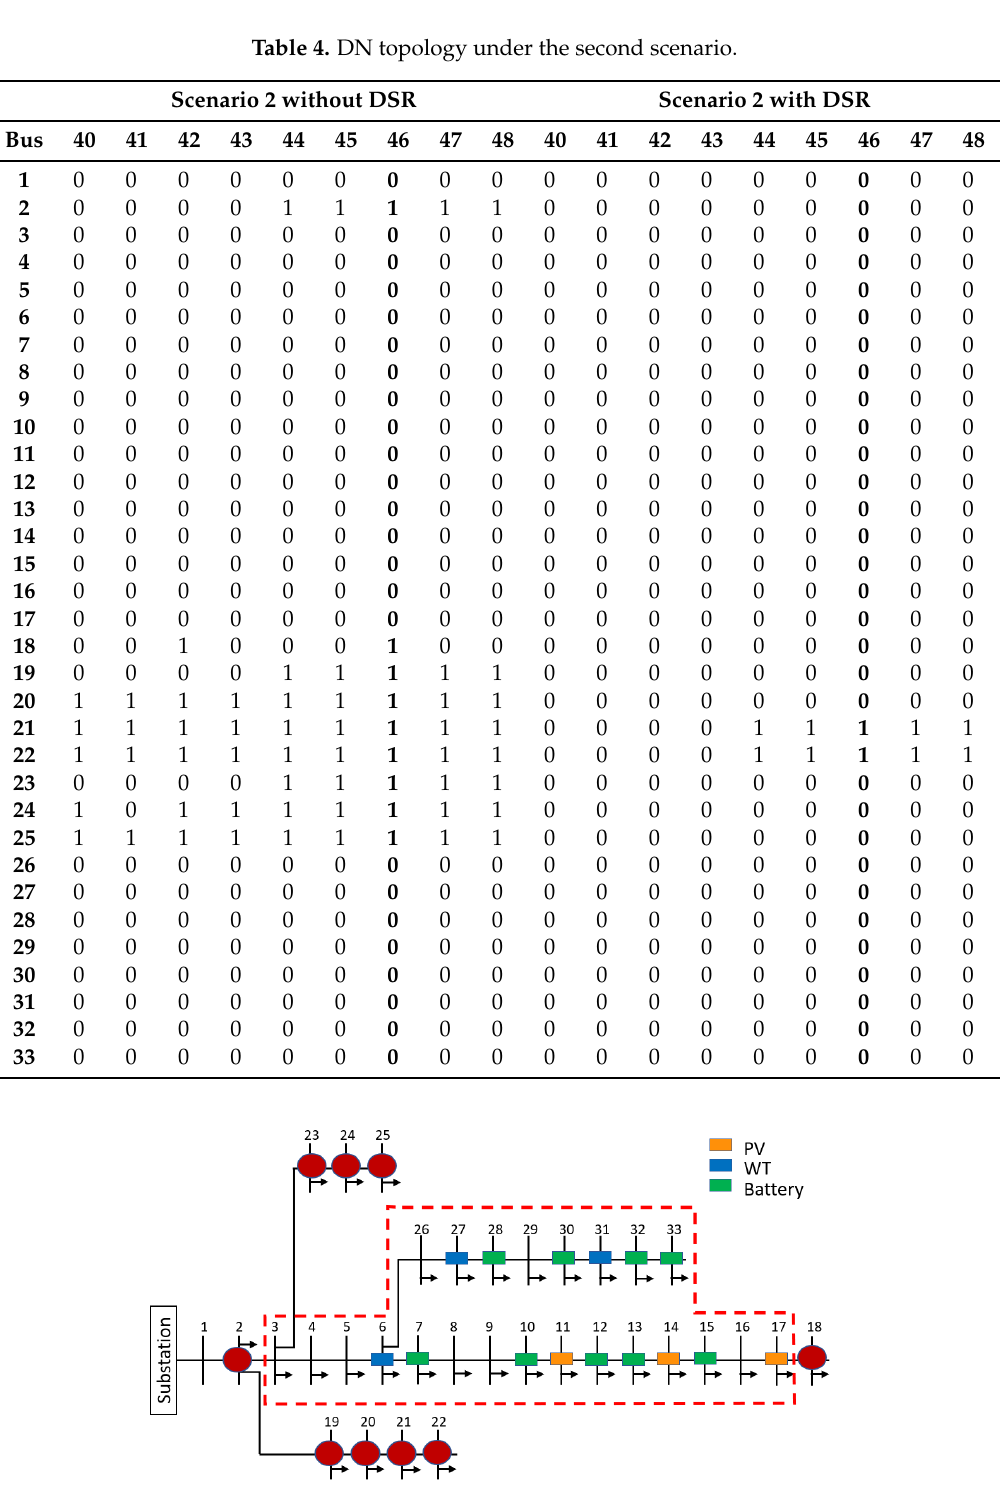
Figure 6. PG&E 33-bus radial DN partitioning for the second scenario at 46 h. Red balls indicate the loads reduced to zero, without considering DSR in the